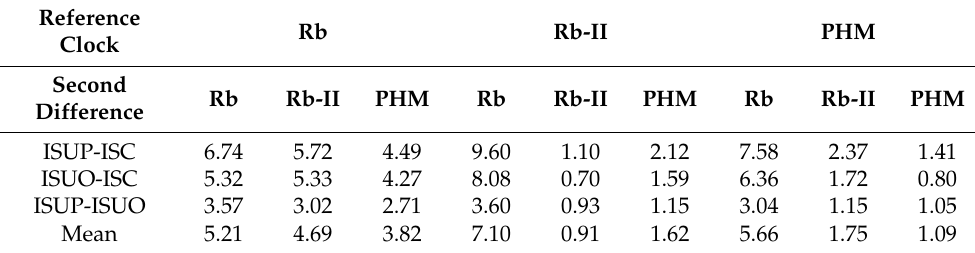
Table 3. The average accuracy statistics of different reference clocks for 13 days